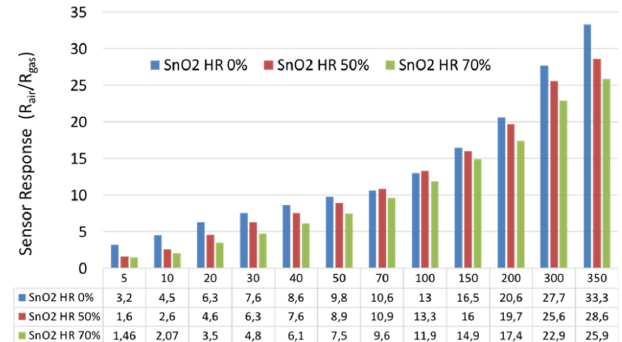
Figure 11. A comparison between the sensor responses to the presence of dry air at 50% of RH and 70% of RH.